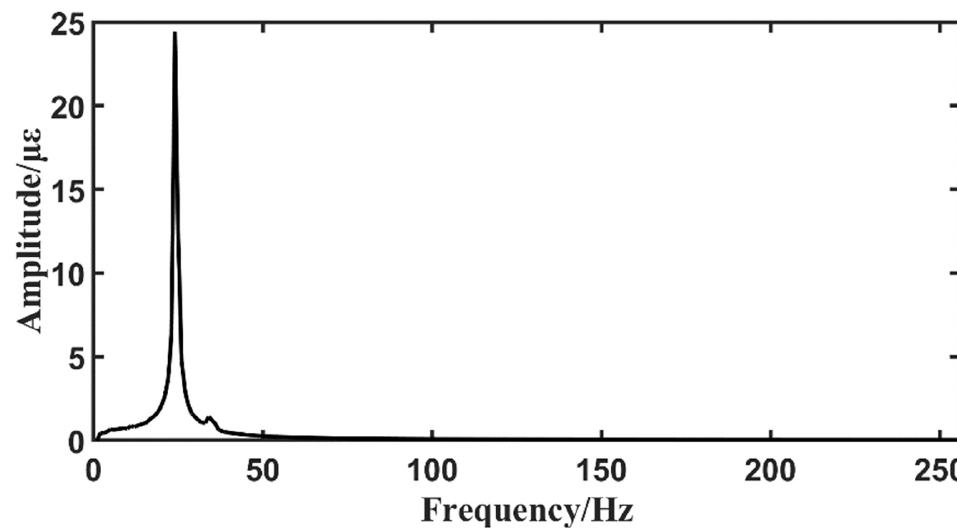
Figure 13. Filtered frequency-domain signal.